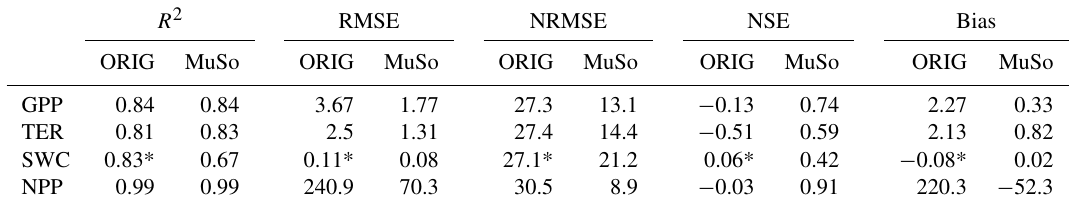
Table 5. Quantitative model evaluation of simulation for deciduous broad-leaved forest for the Jastrebarsko forest site using different error metrics. ORIG means the original Biome-BGC, while MuSo refers to the BBGCMuSo. See text for the definitions of the error metrics. R 2 RMSE